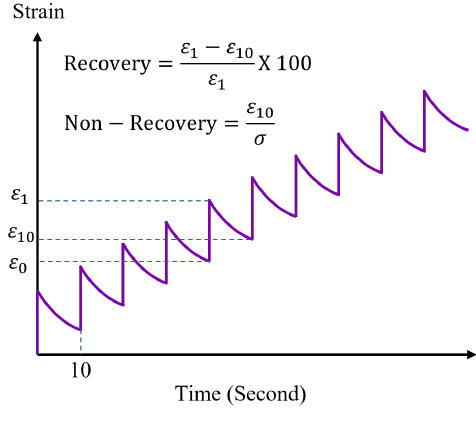
Figure 2. Typical MSCR test